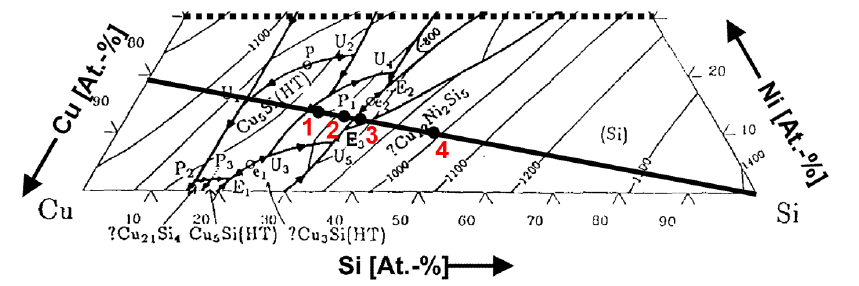
Figure 2. Section of the ternary system Cu–Ni–Si with the working line (points 1 to 4 of the composi- tion for the cooling curves).